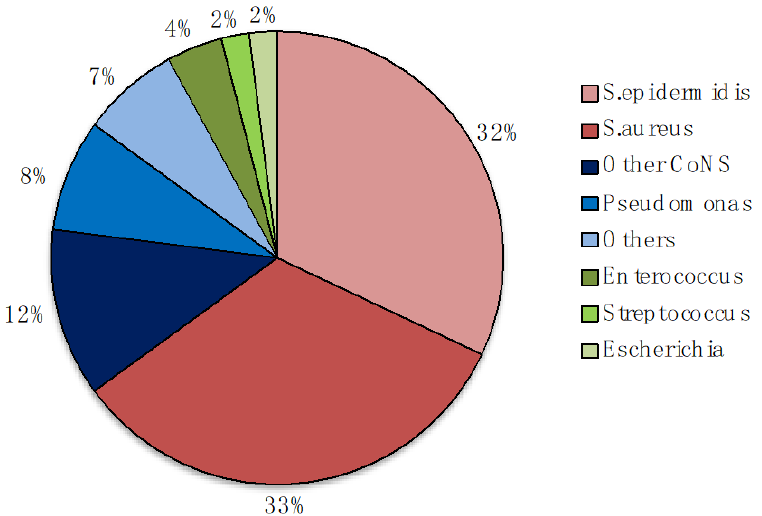
Figure 1. Major microorganisms (MO) associated with implants contamination in orthopedic field. Adapted from [32,42,46]. CoNS—Coagulase-negative staphylococci other than Staphylococcus epidermidis.